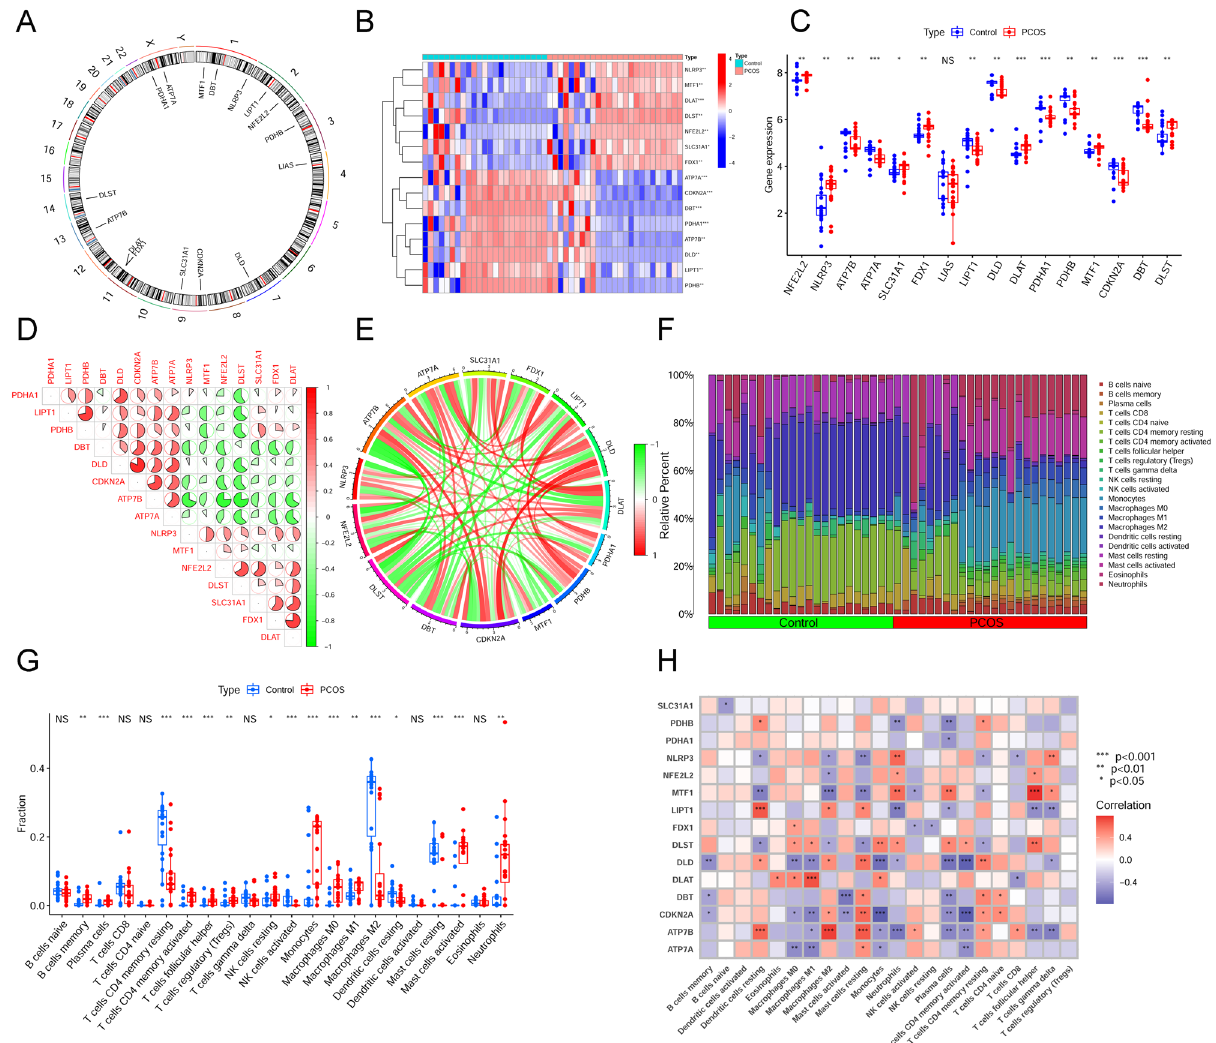
CRGs between PCOS and control group was shown in boxplots. ("***" = P < 0.001, "**" = P < 0.01, "*" = P < 0.05, "NS" = no significance) ( D ) Correlation analysis of 15 differentially expressed CRGs. Colors red and green indicate correlations that are positive and negative, severally. The pie chart area corresponds to the correlation coefficients. ( E ) Gene relationship circos plot of 15 differentially expressed CRGs. The darker the color of the line, the more significant the correlation. ( F ) Bar plot displayed the relative percent of 22 infiltrated immune cells between PCOS and control group. ( G ) The differences in immune infiltrating between PCOS and control group were shown in boxplots. ("***" = P < 0.001, "**" = P < 0.01, "*" = P < 0.05, "NS" = no significance) ( H ) Correlation analysis between 15 differentially expressed CRGs and infiltrated immune